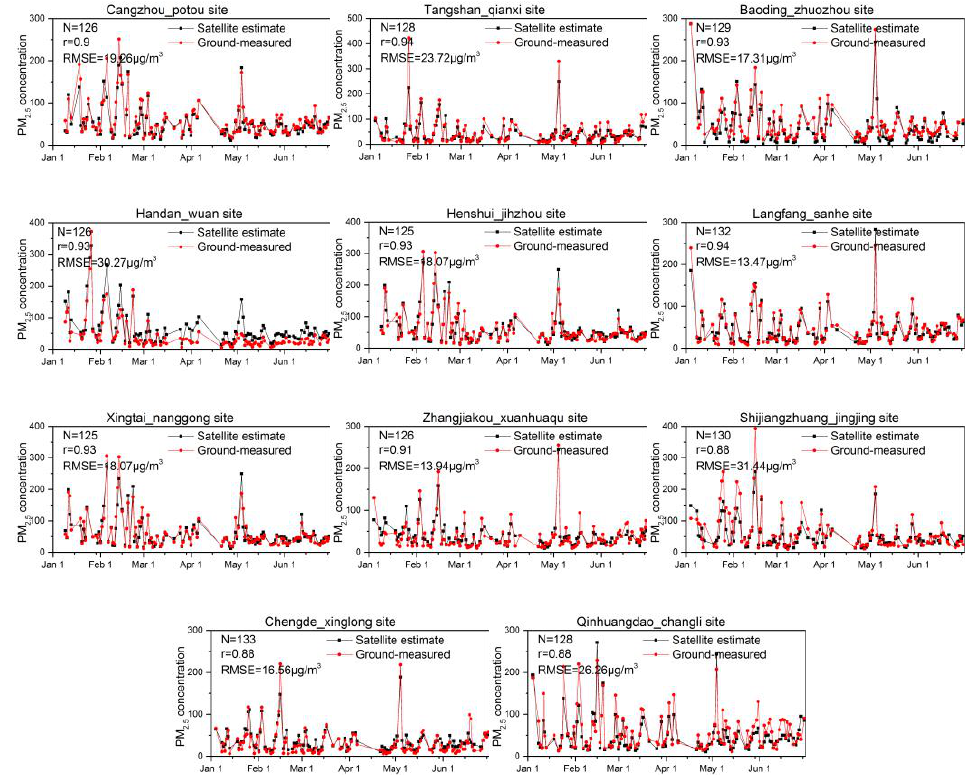
Figure 10. Daily averaged PM 2.5 of satellite-retrieved and ground-measured PM 2.5 data at Baoding-